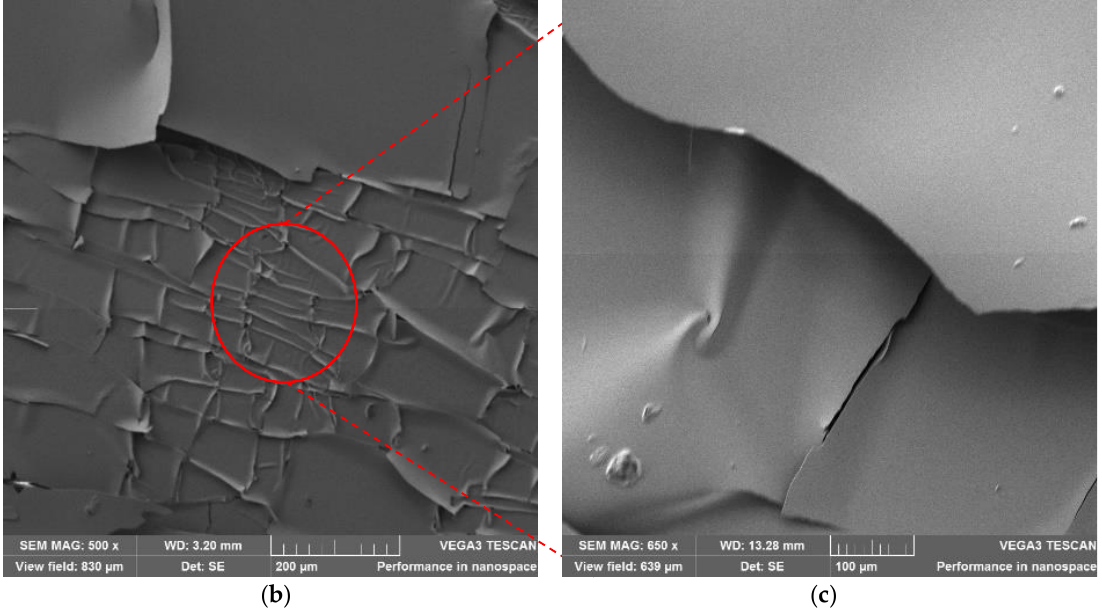
Figure 12. SEM microscopic images of the horseshoe patterns printed on: ( a ) an unstretched sample; ( b ) a 27% radially pre-stretched sample at 200 µm scale; and ( c ) a 27% radially pre-stretched sample at 100 µm scale.